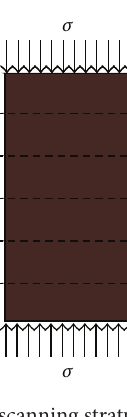
Figure 4: The scanning stratum positions of